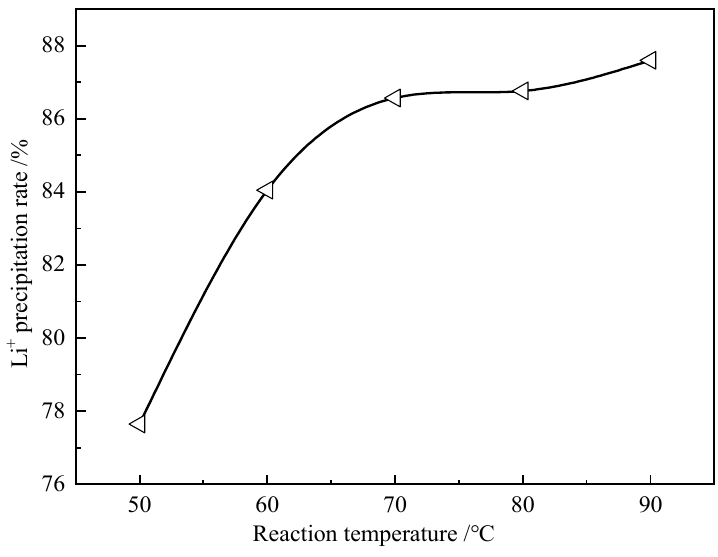
Figure 9. The relationship between reaction temperature and Li + recovery. Table 3. The Gibbs Free Energy Change of the Reaction of Na 3 PO 4 and LiCl at 50–100 °C (by HSC Chemistry 6.0 software (Outokumpu, France)).